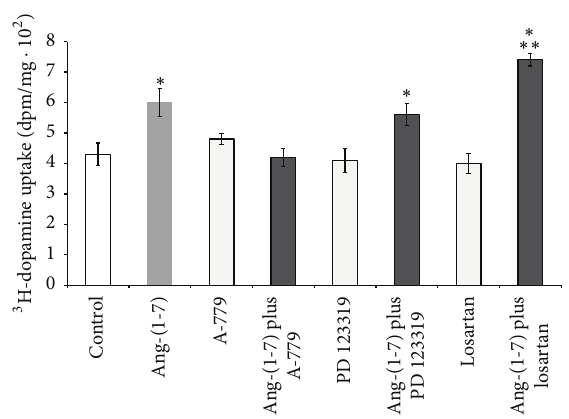
Figure 6: Effects of 100 nM Ang-(1-7) in the presence of 100nM A-779 or 100nM PD123319 or 100 nM losartan on 3 H-dopamine uptakeinrenalcortex. 3 H-dopamineuptakeisexpressedasdpm/mg ± SEM. ∗ 𝑝 < 0.05 comparedwithcontrol. ∗∗ 𝑝 < 0.05 comparedwith Ang-(1-7) or Ang-(1-7) plus PD123319. Number of samples: 8–12.